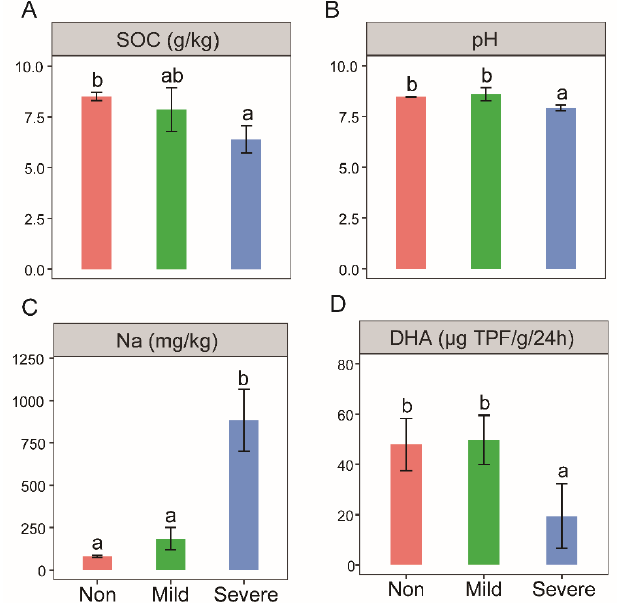
Figure 1. SOC contents ( A ), pH ( B ), Na contents ( C ) and dehydrogenase activities ( D ) of the soils with three salinity levels: Non–salinity, Mild–salinity and Severe–salinity. Different letters above bars denote significant differences ( p < 0.05) among salinity levels.